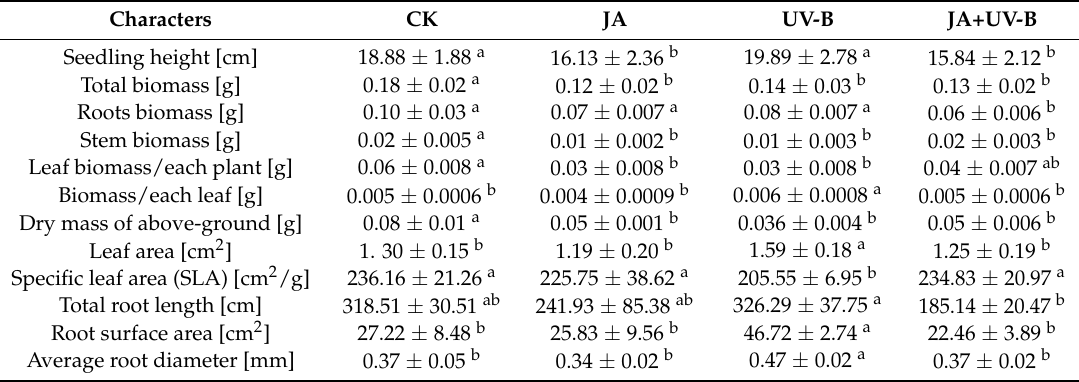
Table 3. JA and UV-B radiation effects on growth parameters and phenotyping analysis of root system architecture of Scutellaria baicalensis Georgi. CK (the control), JA (seedlings were sprayed with 1 mM JA), UV-B (seedlings were treated with 15-d elevated UV-B radiation), JA+UV-B (seedlings were sprayed with 1 mM JA before additional 15-d UV-B radiation). Data are means ± S.E., error bars are means of three replicates. Different lowercase letters are significantly different at p < 0.05 according to Duncan’s multiple range